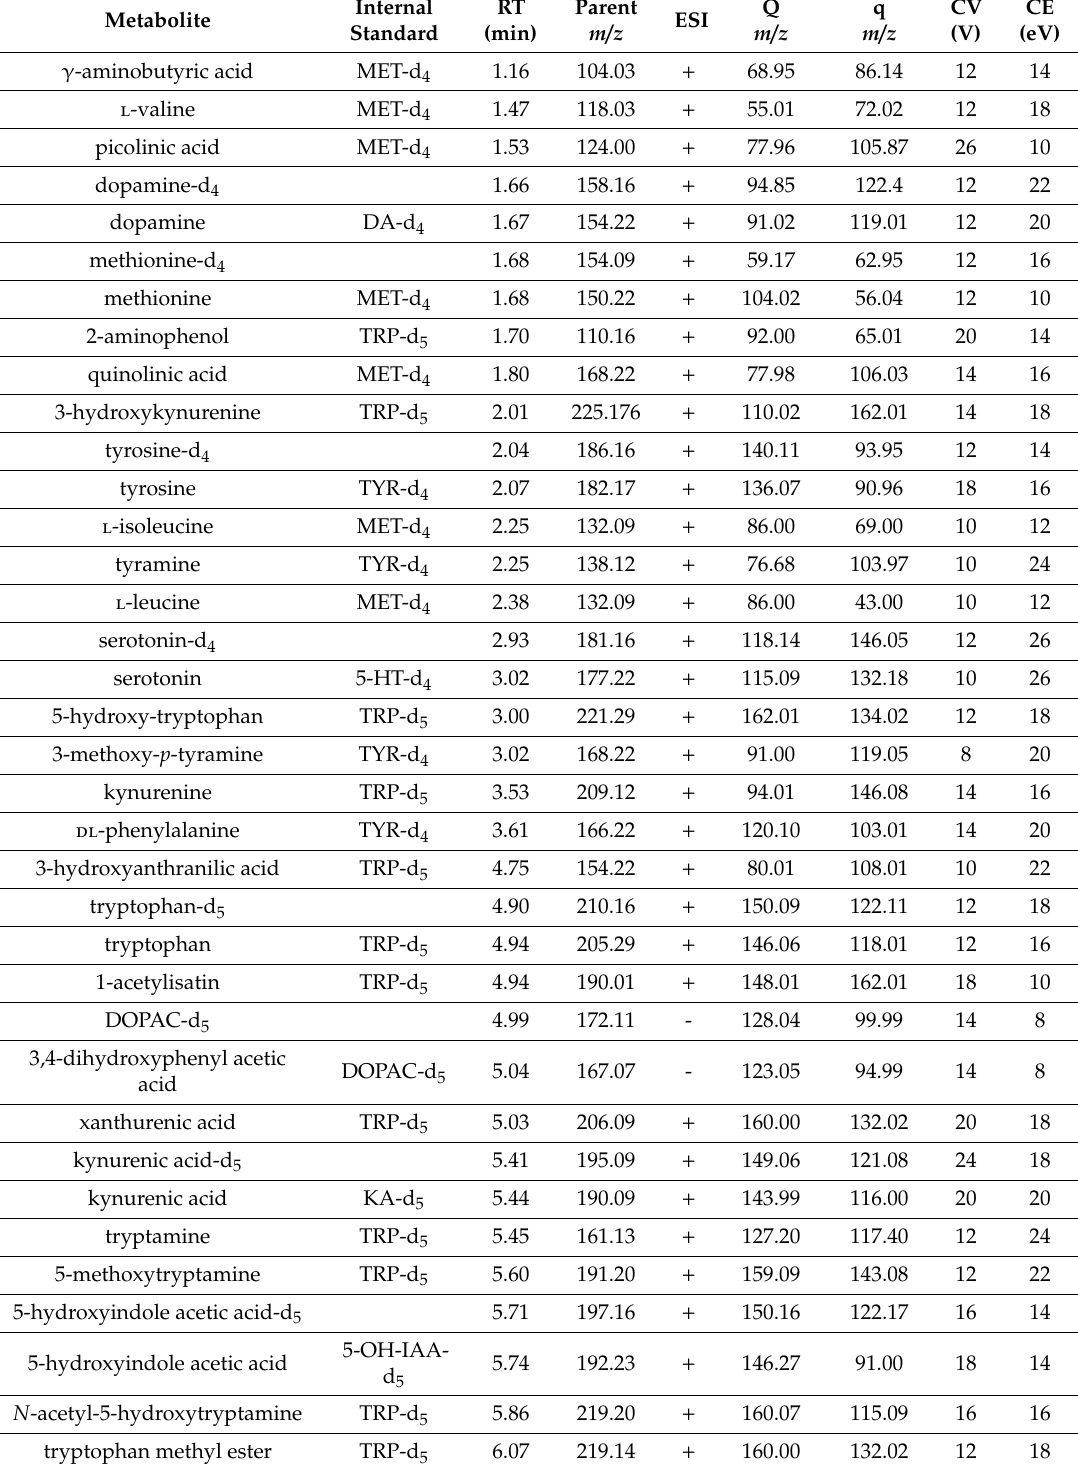
Table 1. Internal standard used for quantification, RT (min) and MS parameters (parent m / z , polarity, quantifier and qualifier ions m / z , CV and CE) for the selected analytes. A Waters ACQUITY